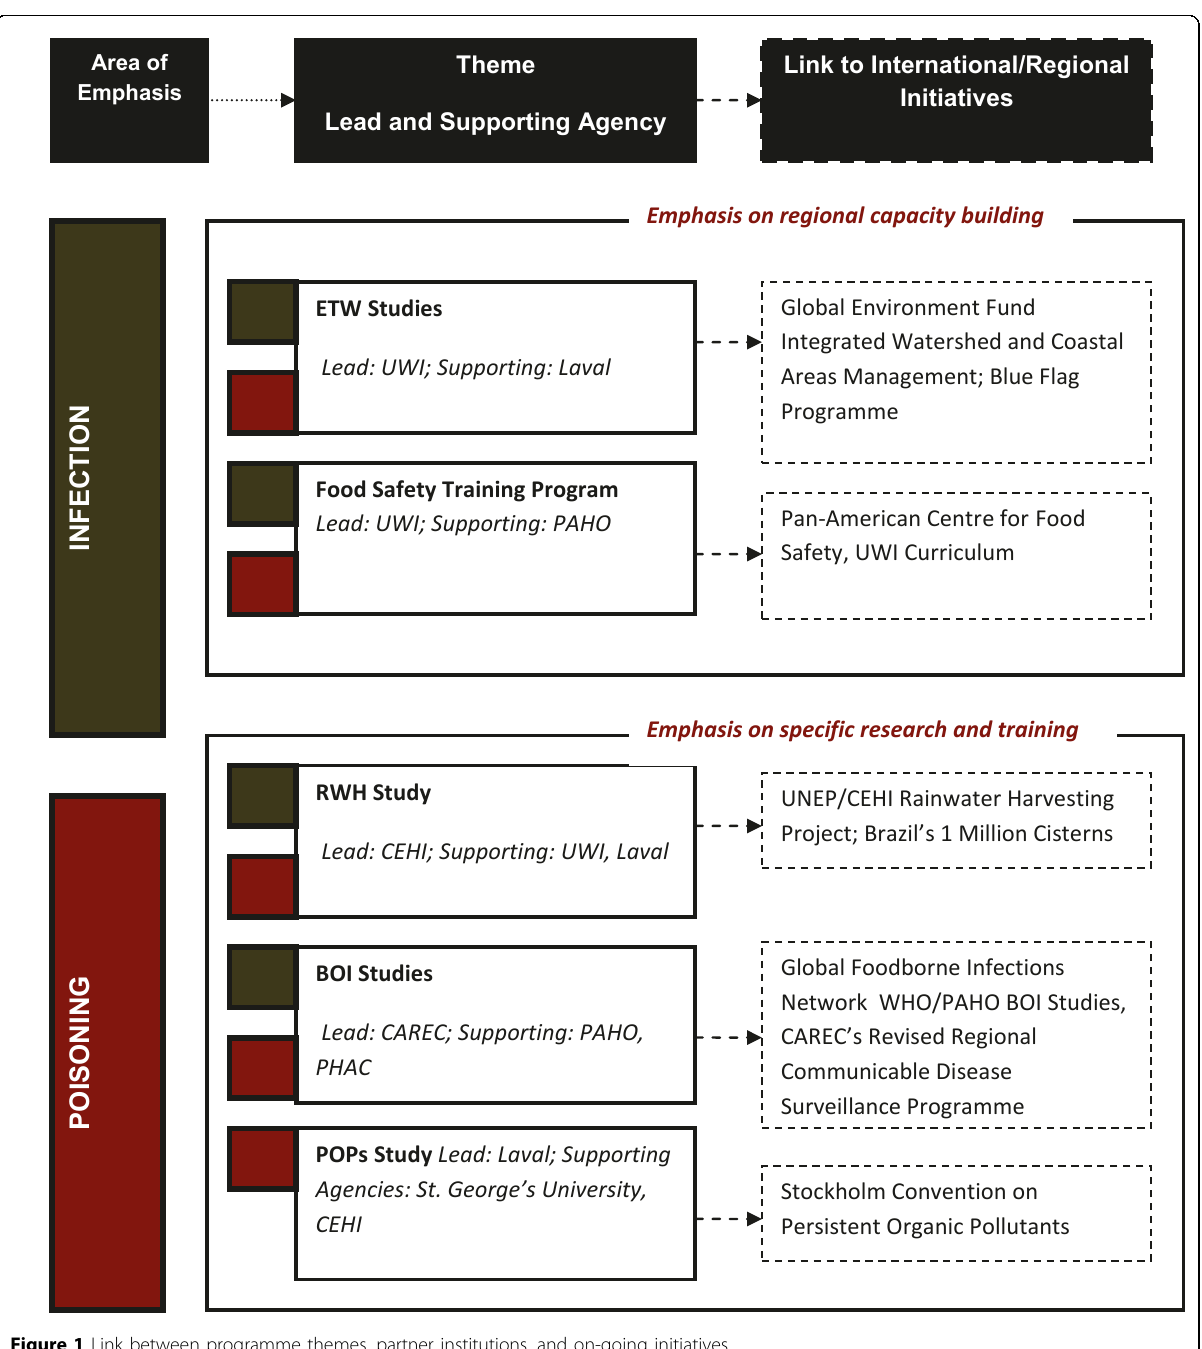
Figure 1 Link between programme themes, partner institutions, and on-going initiatives. Table 1 Emergent research themes, and lead and supporting institutions of the Caribbean EcoHealth Programme. Emergent Research